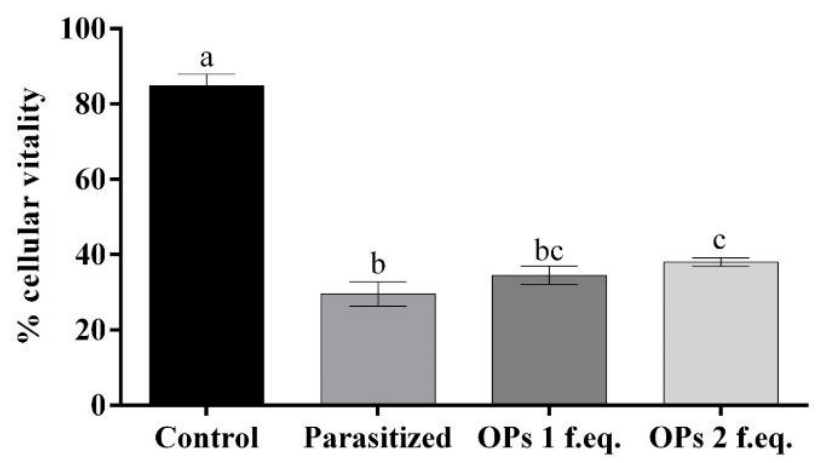
Figure 1. Percentage of haemocyte viability incubated with 1× PBS (control), haemocytes extracted from larvae 24 h after parasitization, haemocytes incubated with Ovarian Proteins (OPs) deriving from 1 or 2 equivalent females. Data are presented as means ± SD ( n = 3 replicates). Statistical analysis was performed with one-way ANOVA and Tukey post-hoc test. Different letters indicate significant differences ( p value < 0.0001).